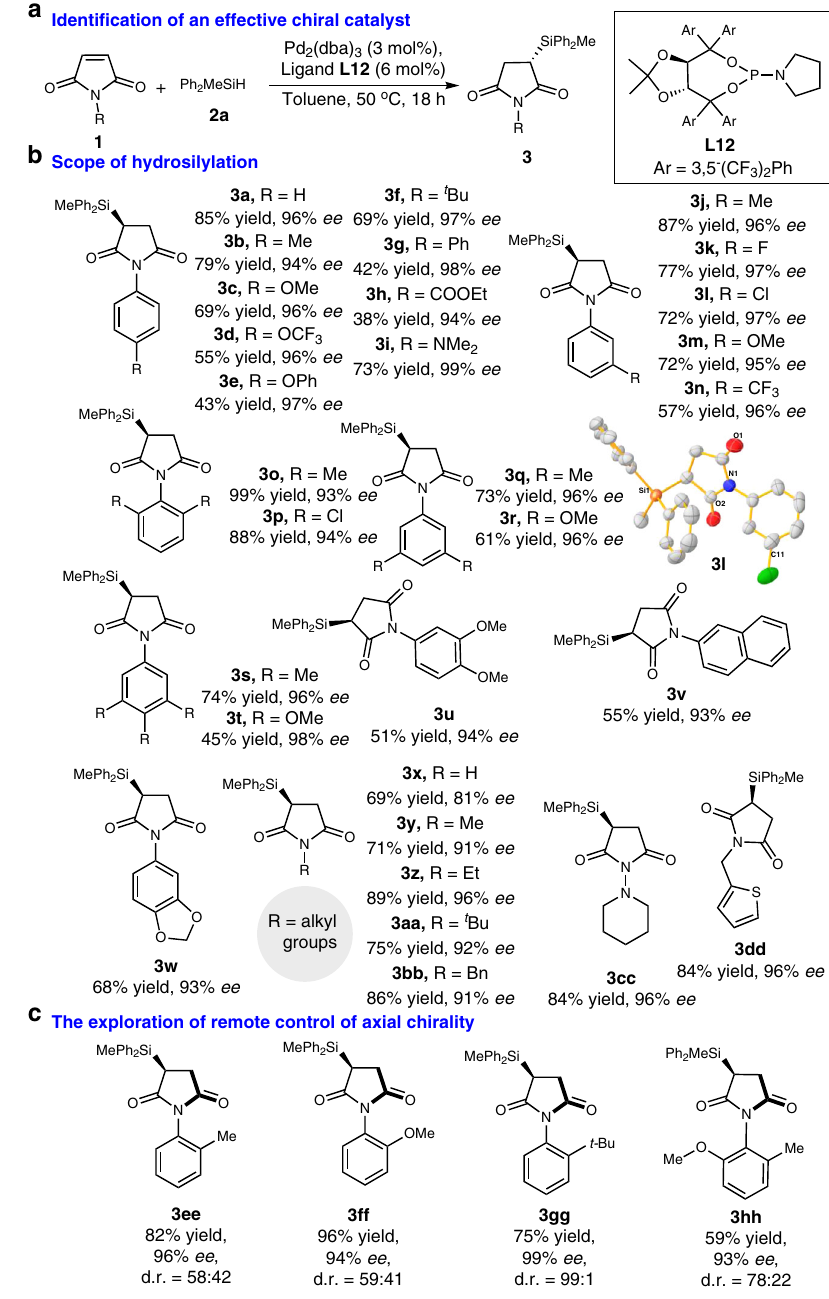
Fig. 2 Enantioselective palladium-catalysed hydrosilylation of maleimides. a The determination of chiral palladium catalyst after screening of a variety of chiral ligands and reaction parameters, and that corresponding to L12 is optimal. b The catalytic asymmetric hydrosilylation of maleimides is broadly applicable, affording silyl products with excellent enantioselectivities (up to 99% ee ). Products containing S-heterocycle and unsubstituted imide can be accessed. c The effect of bulky groups at the ortho -position of N -arylmaleimides on enantioselective Si – C coupling hydrosilylation with respect to the remote control of axial